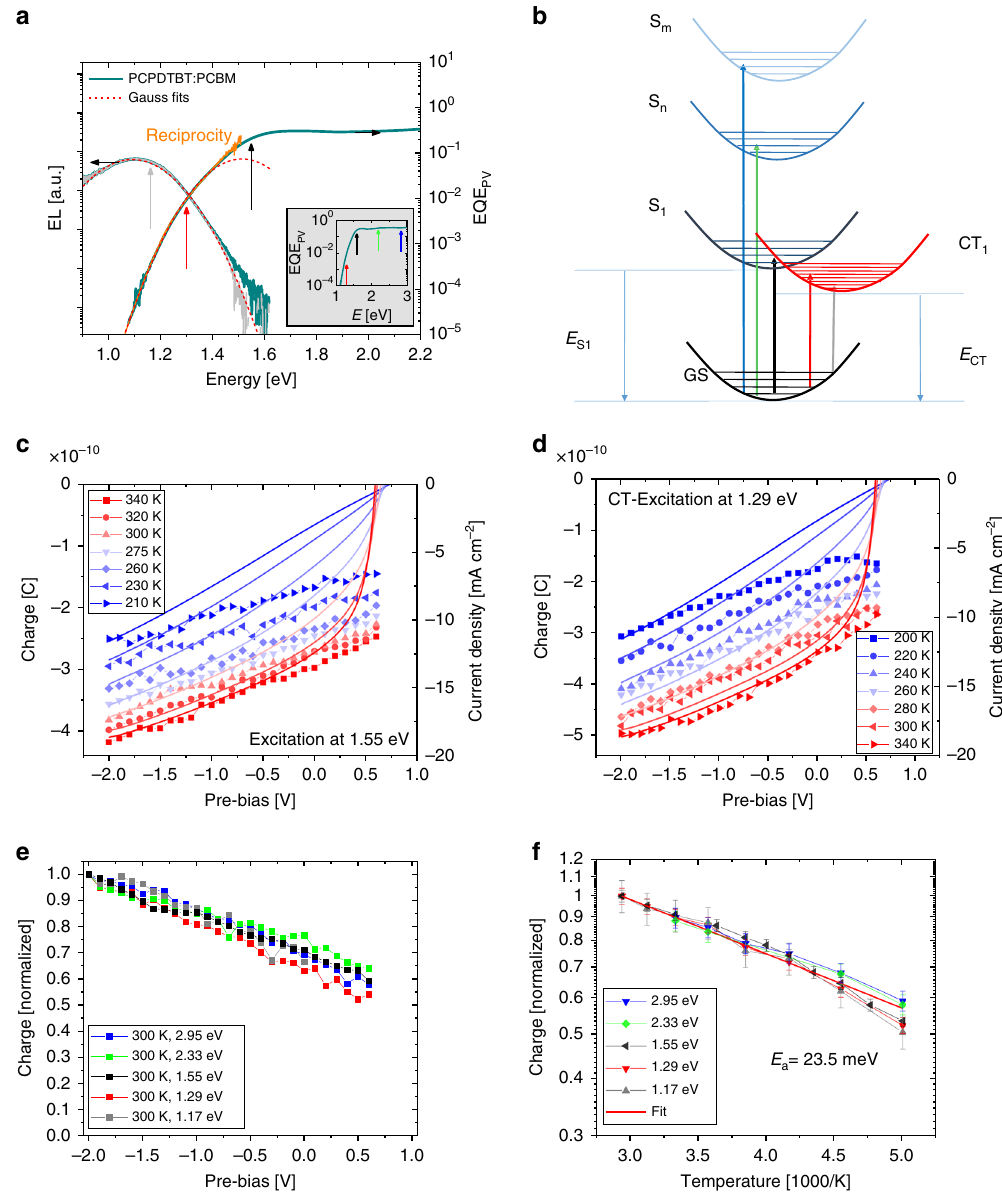
Fig. 3 Charge generation as a function of fi eld, temperature, and excitation energy: a EQE of the PCPDTBT:PCBM blend (dark green, right axis) compared to the electroluminescence spectrum measured for a low injection current of 0.1 mA cm − 2 (dark green, left axis), both at room temperature. Also shown is the EQE calculated from the EL spectrum with Rau ’ s reciprocity relation (orange). The red lines are the Gaussian fi ts to the EL (minus the EL of the neat polymer) and low energy EQE, providing a CT energy of 1.3 eV. The arrows in the inset indicate the excitation energies in the TDCF experiments. b Schematic energy diagram of the PCPDTBT:PCBM blend with the optical transitions used in the TDCF experiments, arrows again indicate the excitation energies. c , d Bias-dependent charge generation (symbols) in a PCPDTBT:PCBM blend for different temperatures measured with TDCF for excitation above (1.55 eV) and below (1.29eV) the optical band gap of the polymer. The collection voltage was − 3 V, which is suf fi cient to completely extract photogenerated charges at all temperatures. Solid lines are current – voltage characteristics measured under illumination with a halogen lamp with the intensity adjusted to yield nearly the same current as under AM1.5 G illumination. e Photogenerated charge as function of bias at room temperature (normalized to its value at − 2 V) for excitation at 2.95, 2.33, 1.55, 1.29, and 1.17 eV at room temperature. f Temperature dependence of the photogenerated charge in the low fi eld plateau region for different excitation wavelengths. The solid line is the best fi t to the data to an Arrhenius-type temperature dependence, yielding an activation energy of 23.5 ± 3.4 meV. Error bars indicate the standard